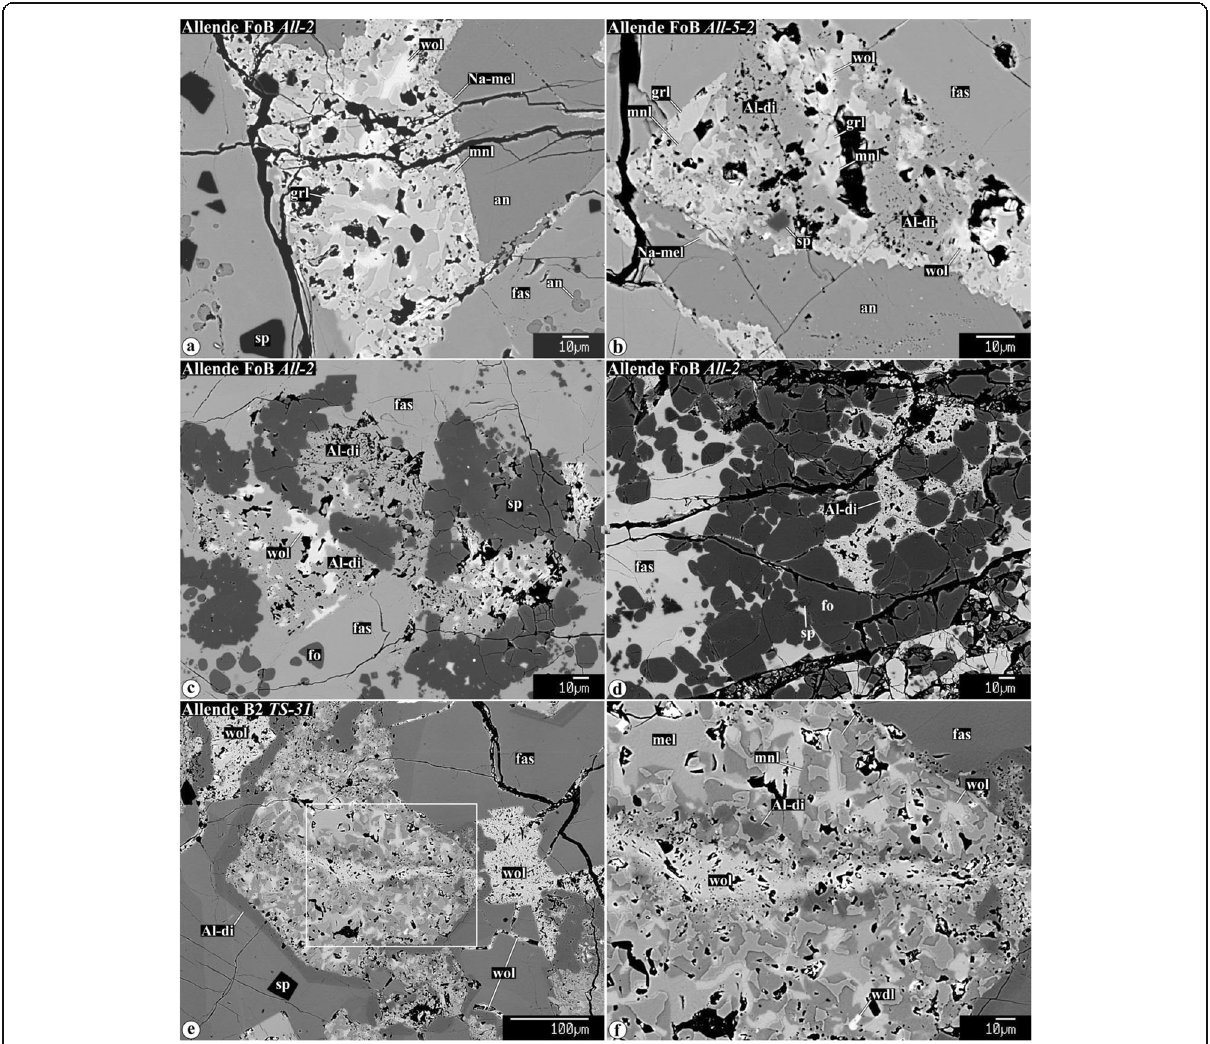
Fig. 9 Backscattered electron images of multiple generation of secondary mineral assemblages in the Allende Type B CAIs. Region outlined in e is shown in detail in f . a − d Replacement of grossular-monticellite-wollastonite assemblages to various degrees by Al-diopside. e , f Grossular- monticellite-wollastonite-Al-diopside assemblage is crosscut by a wollastonite vein. Wollastonite also fills veins and irregularly shaped regions in